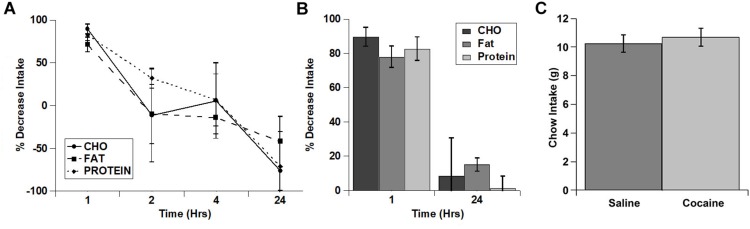
Cocaine inhibited the intake of all three test diets to a similar extent and did not alter post-test home cage chow intake. (A) % decrease in intake of each of the diets during each individual time period (Non-cumulative). (B) % decrease in cumulative intake of each of the diets at 1 and 24 h post-injection. (C) Post-test, 24 h home cage chow intake. n = 5–11 (A,B). n = 12 (C).